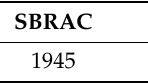
Table 6. Apparent density of coarse